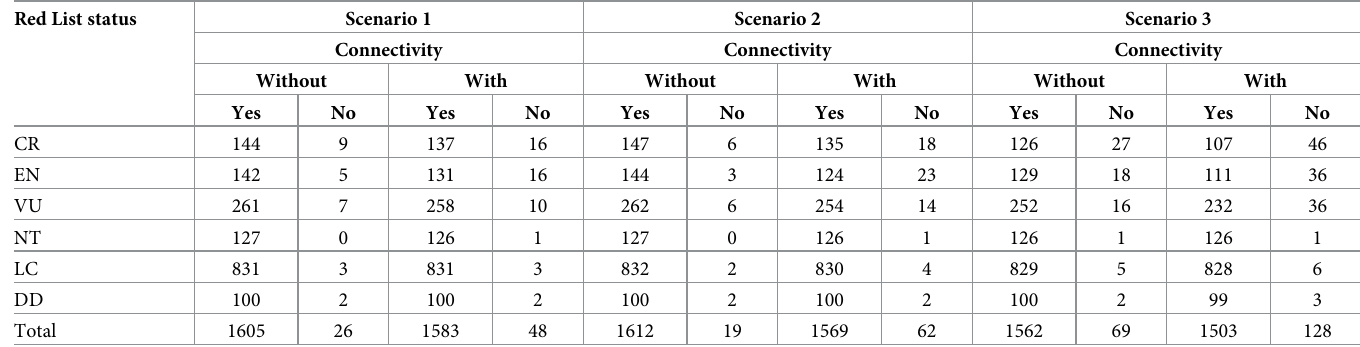
Our study represents a first attempt at continental-scale conservation prioritization based on a large database of freshwater biodiversity and catchments as planning units, which Table 1. Number of species of different Red List conservation status for which representation targets were met (Yes) or not met (No) in the three scenarios, each replicated without or with connectivity. Red List status Scenario 1 Scenario 2 Scenario 3